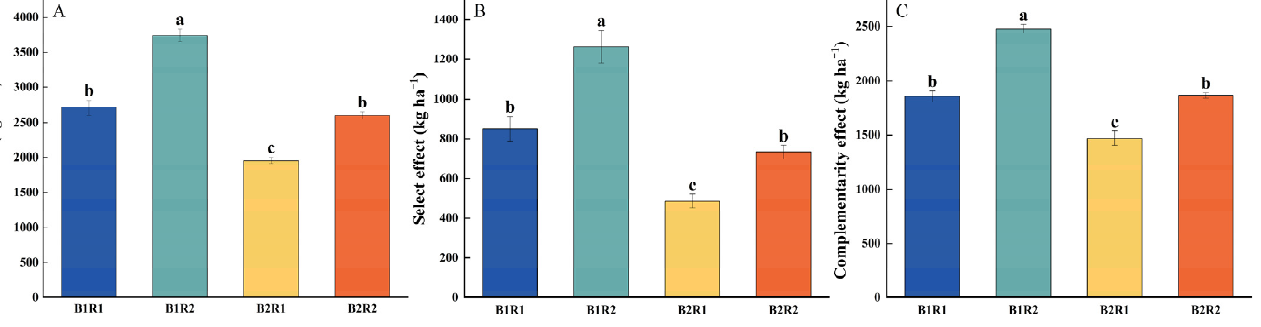
Figure 6. ( A – C ) indicate the net effect, select effect, and complementarity effect, respectively. Differently colored bars indicate different intercrop treatments. Lowercase letters above the bars indicate significant differences ( p < 0.05). Values are means ± standard error.